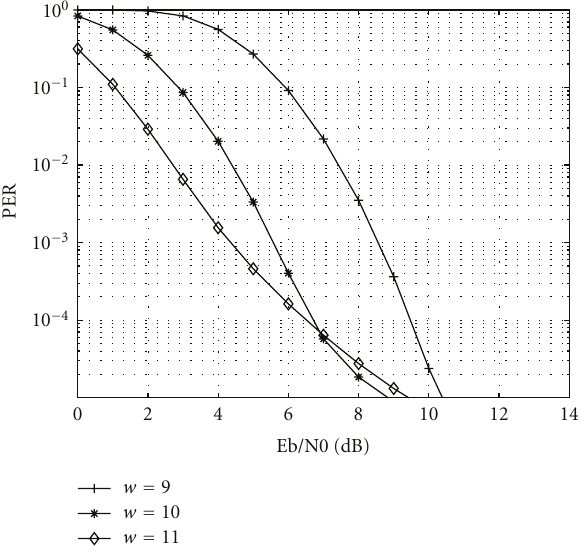
Figure 11: Influence of the number of users on 8-PIM performance for optimal v th and E b /N 0 =